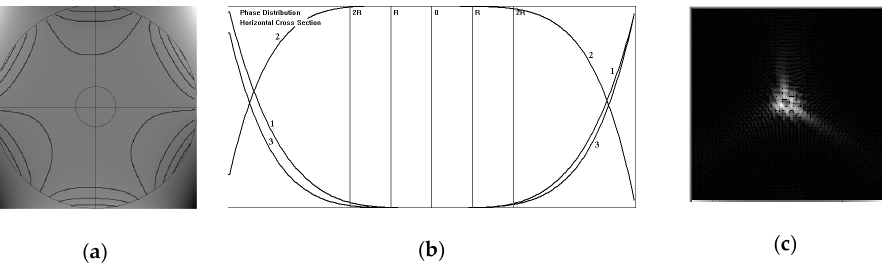
Figure 6. The same as in Figure 2, the phase was specified by the sum of polynomials from 1 to 6. Phase surface ( a ), cross-sections of phase surface ( b ) and corresponding amplitude distribution ( c ) are shown.